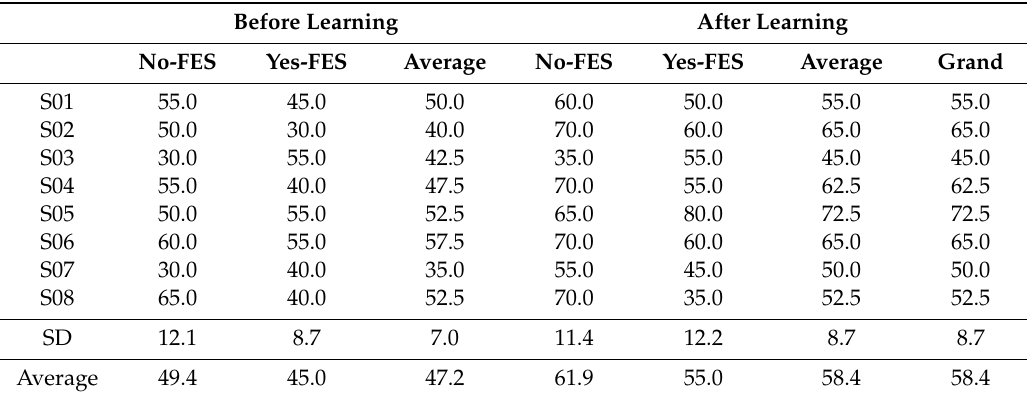
Table 5. Accuracy of each IV (%).